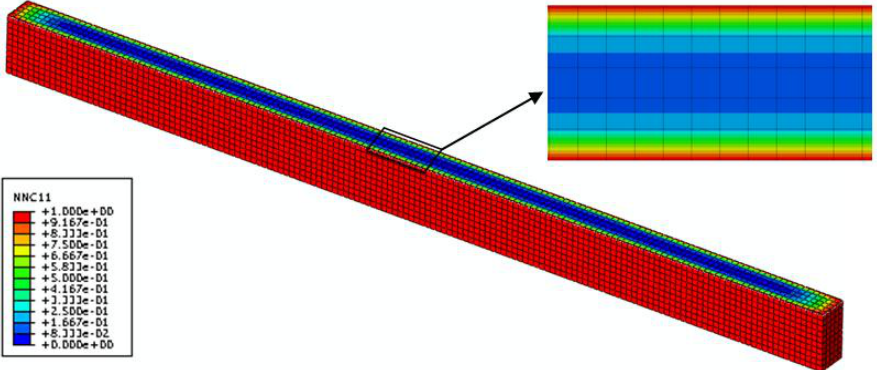
Figure 11. Nominal moisture concentration distribution across the mid-plane of the FRP specimen with 50% moisture uptake content (time = 229 h).